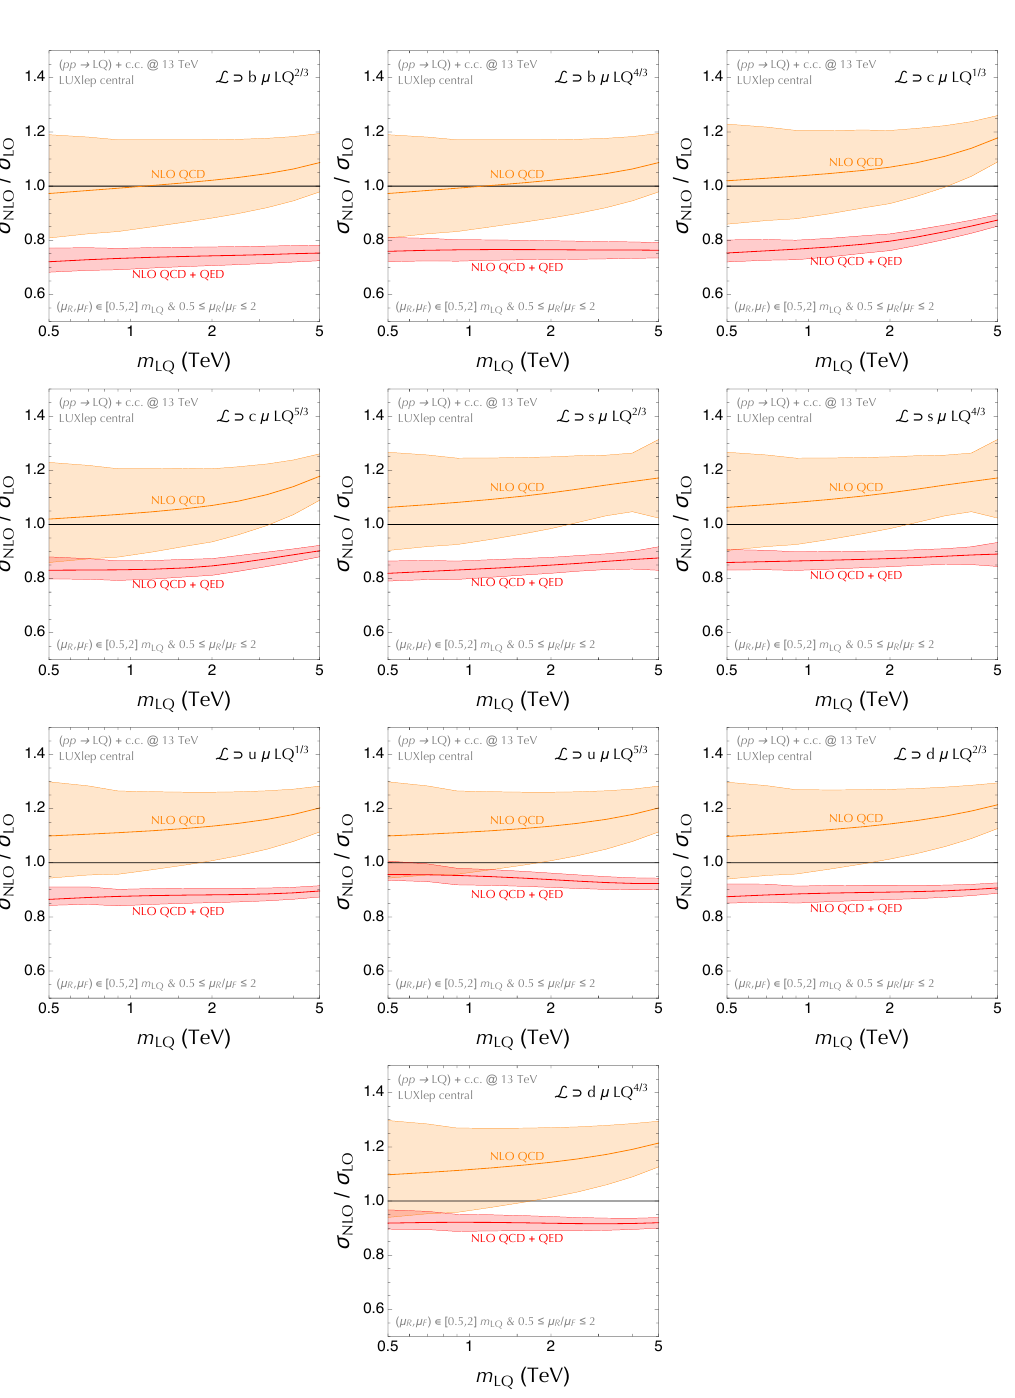
Figure 9 . ( muon ) NLO K -factors ( σ NLO /σ LO ) for resonant scalar leptoquark production at 13 TeV LHC. Shown with orange (red) are the NLO QCD (NLO QCD + QED) predictions normalised to the LO when setting the central scales to µ R = µ F = m LQ . The colored bands are obtained by varying factorisation and renormalisation scales in the NLO calculations within { µ F , µ R } ∈ [0 . 5 , 2] m LQ while respecting 1 / 2 ≤ µ R /µ F ≤ 2 . We use the central PDF set from LUXlep-NNPDF31_nlo_as_0118_luxqed (v2)